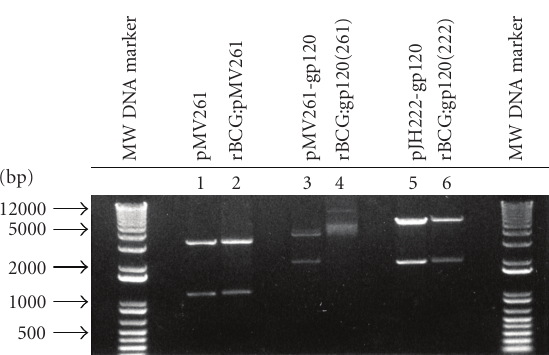
Figure 2: Enzymatic restriction analysis of pMV261::HIV-1gp120 and pJH222::HIV-1gp120 plasmid DNA after BCG transformation. Lane 1 , pMV261 plasmid DNA without HIV-1 gp120 DNA insert digested with BglII; L ane 2 pMV261 plasmid DNA without HIV- 1 gp120 DNA insert from BCG colonies, digested with BglII, Lane 3, pMV261-HIV-1gp120 plasmid DNA digested with SacII; lane 4 , pMV261-HIV-1gp120 plasmid DNA from rBCG:HIV-1gp120 colonies, digested with SacII; lane 5, pJH222-HIV-1gp120 plasmid DNA digested with HpaI and lane 6 , pJH222-HIV-1gp120 plasmid DNA from rBCG:HIV-1 gp120 colonies, digested with HpaI. Plasmid DNAs before BCG transformation (pre-BCG) were used as positive controls (lane 1, 3 and